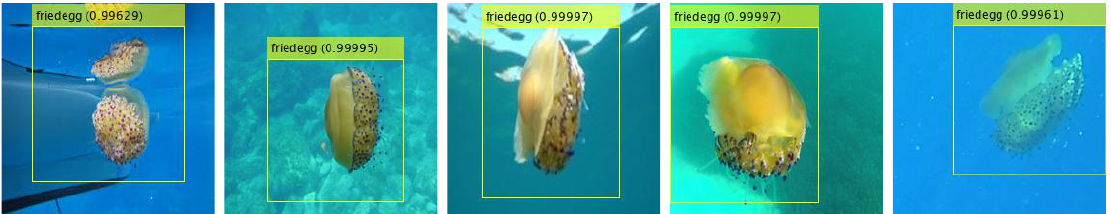
Figure 4. Output by classification model 5 for Carybdea marsupialis (box jellyfish).